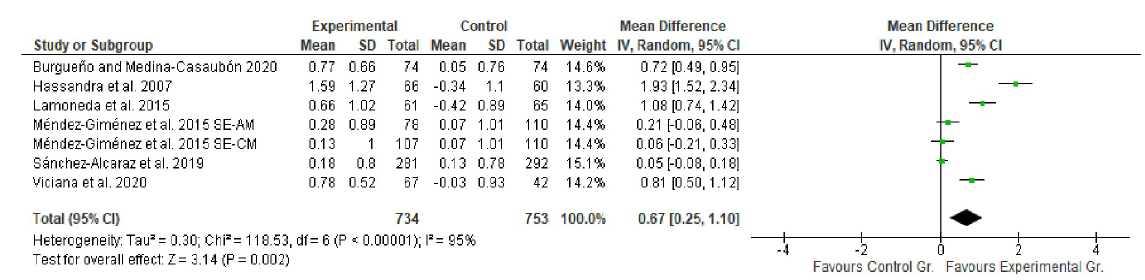
Fig 3. Results of the meta-analysis regarding the effects of interventions on the respect for social conventions.